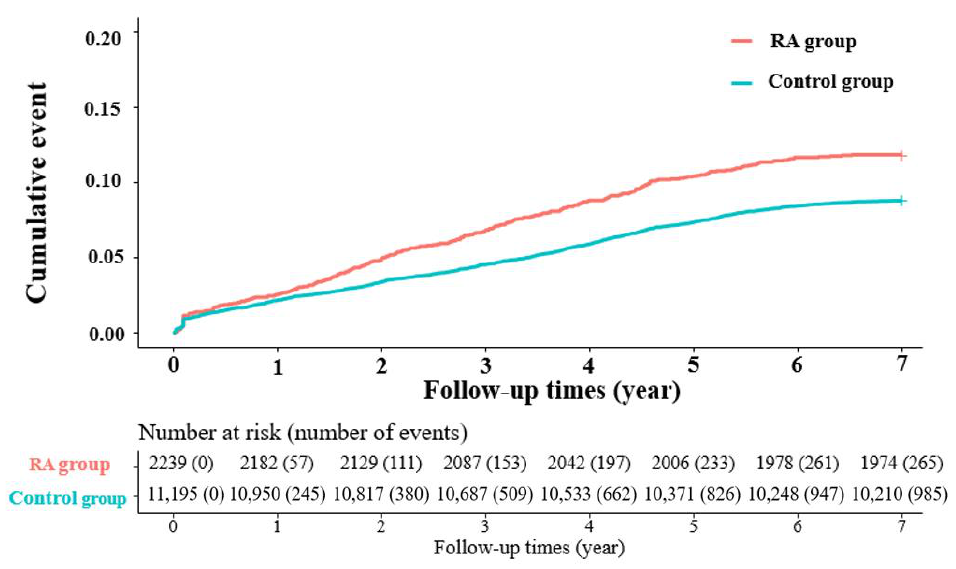
Figure 2. The Kaplan–Meier curves showed significantly higher cumulative reoperation rates in rheumatoid arthritis (RA) patients than in those in the non-RA control group. Table 4. Subgroup analysis of comorbidity factors related to the risk of reoperation in RA